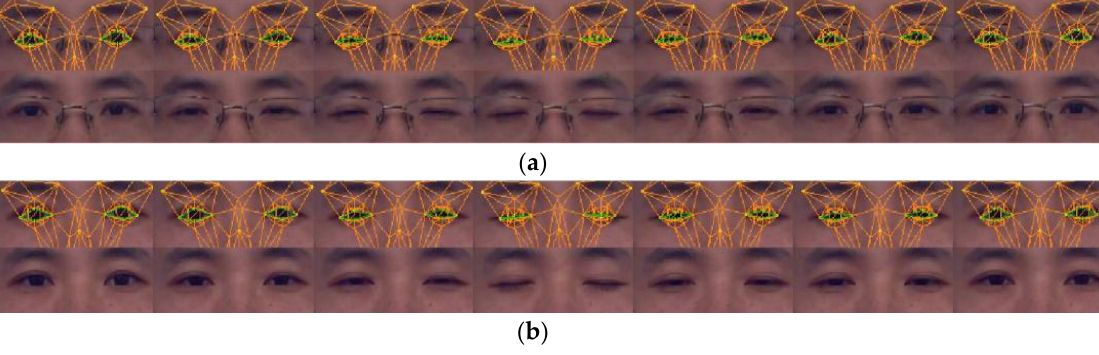
Figure 8. Sample images of eye movement tracking. The tracked eyelid is drawn by green lines. ( a ) Wears a pair of glasses and ( b ) wears no glasses.